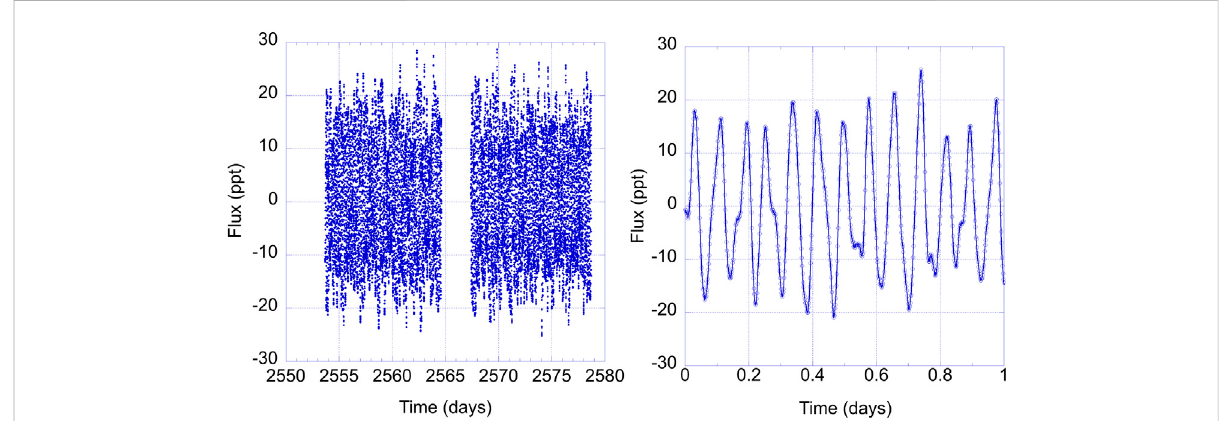
FIGURE 3 Left:FG Vir TESS 2-mincadence lightcurvefrom sector 46, showing 22.84 days ofdata,excludingthe~5-daygap inthemiddle of thedata set. Time is measured after barycentric Julian day 2457000. Right: Zoom-in on TESS light curve on day 2560. Small features are resolved that were not resolved using K2 30-min cadence data.